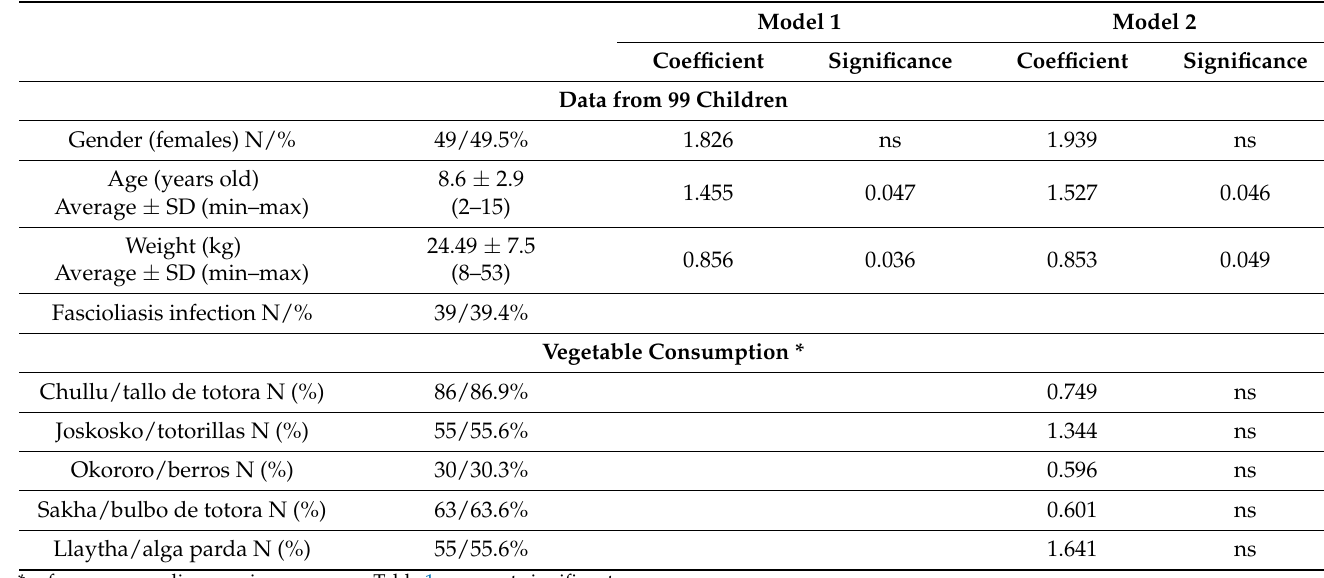
Table 5. Multivariate logistic regression analysis of different data obtained from children and their answers on vegetable consumption in the locality of Cutusuma in the Northern Bolivian Altiplano human fascioliasis hyperendemic area, and regression coefficients [Exp(B) = RR = relative risk of fascioliasis determined by coprodiagnosis] with significance in two models including presence/absence of liver fluke infection as dependent variable: Model 1 , including gender, age, and weight of children as independent variables; Model 2 , including gender, age, and weight of children, plus positive answers on consumption of the five listed vegetables as independent